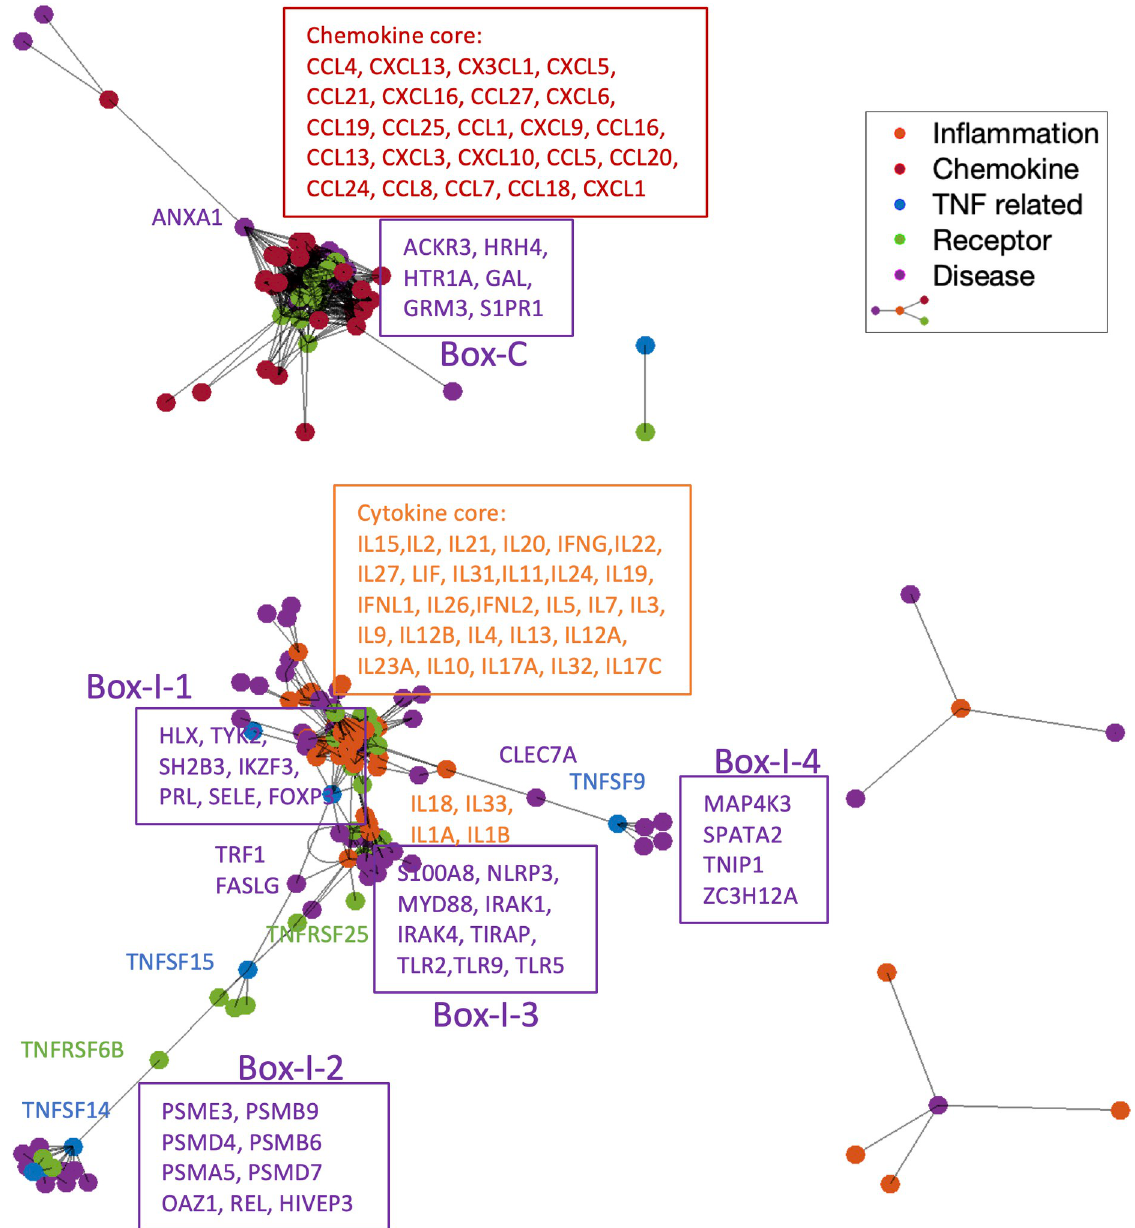
Fig 10. SLE subnetwork formed between pathogenesis genes (green and purple) and inflammatory responses (orange, red, blue). The graph was plotted using a force-directed layout that uses attractive forces between adjacent nodes and repulsive forces between distant nodes. The distances between two vertices are roughly proportional to the length of the shortest path between them. Six genes (ACKR3, HRH4, HTR1, GAL, GRM3, S1PR1) in Box-C are making high degree contacts with the chemokine core (red box), with ANXA1 interacting with 16 chemokines. Interactions with the inflammation core (orange box) appear in multiple directions. Seven pathogenesis genes (Box-I-1) interact with the inflammation core (orange box) directly or through receptors (green nodes). Nine disease genes in Box-I-3 form a small core with four cytokines (IL18, IL22, IL1A and IL1B). Two other groups of genes (Box-I-2 and Box-I-4) appear distant from the cytokine core but are linked to the TNFs, as they cannot overcome the repulsive force to association with the center of inflammation responses.